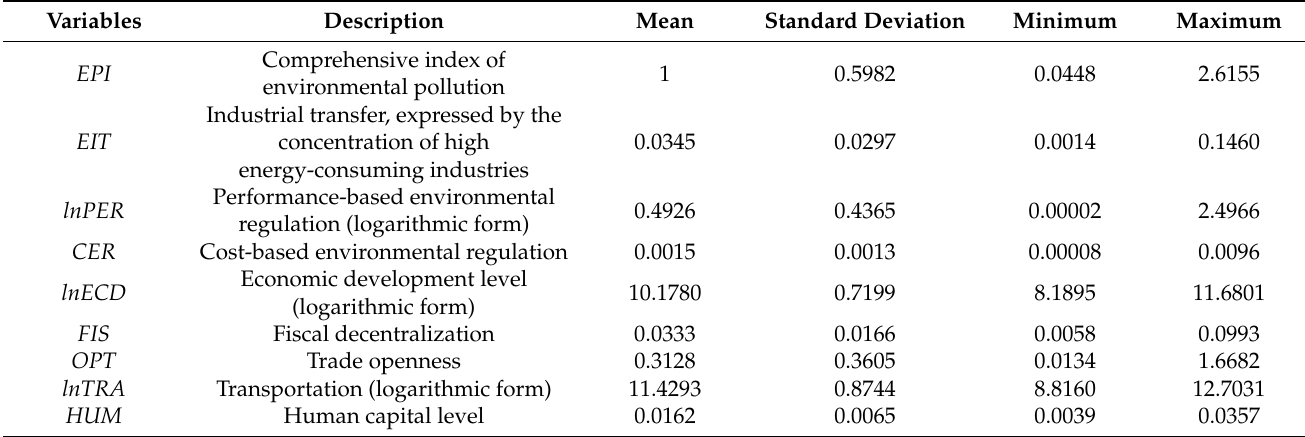
Table 1. Descriptive statistics of variables.